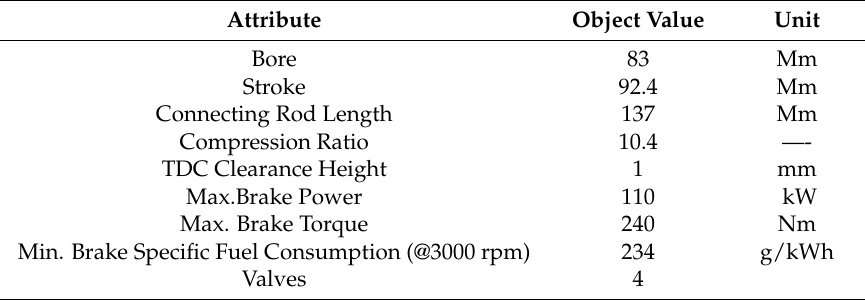
Table 8. The operating points that were used for the simulation.